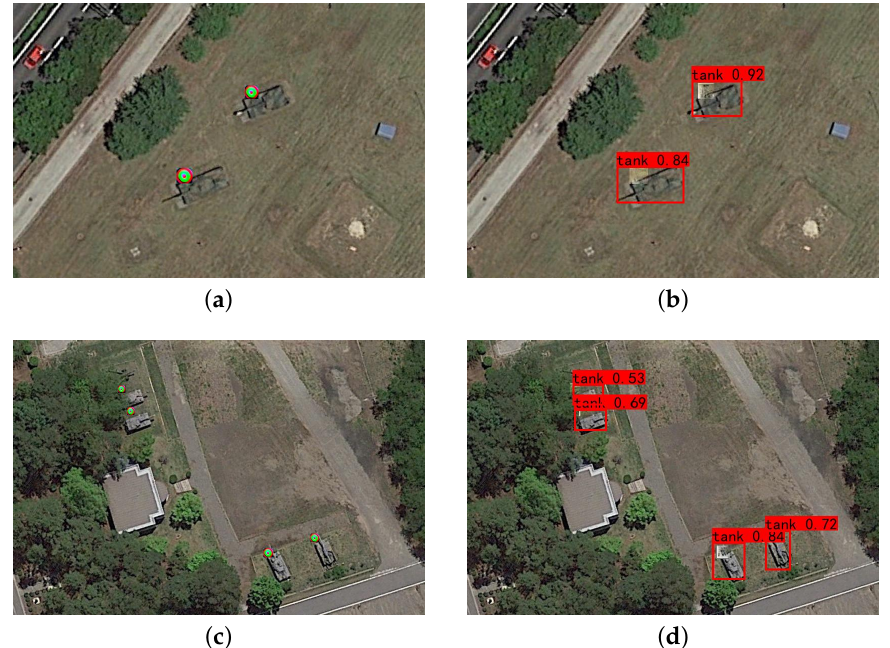
Figure 9. ( a , c ) place the adversarial patch next to the detection target; ( b , d ) use our algorithm to detect figure ( a , c